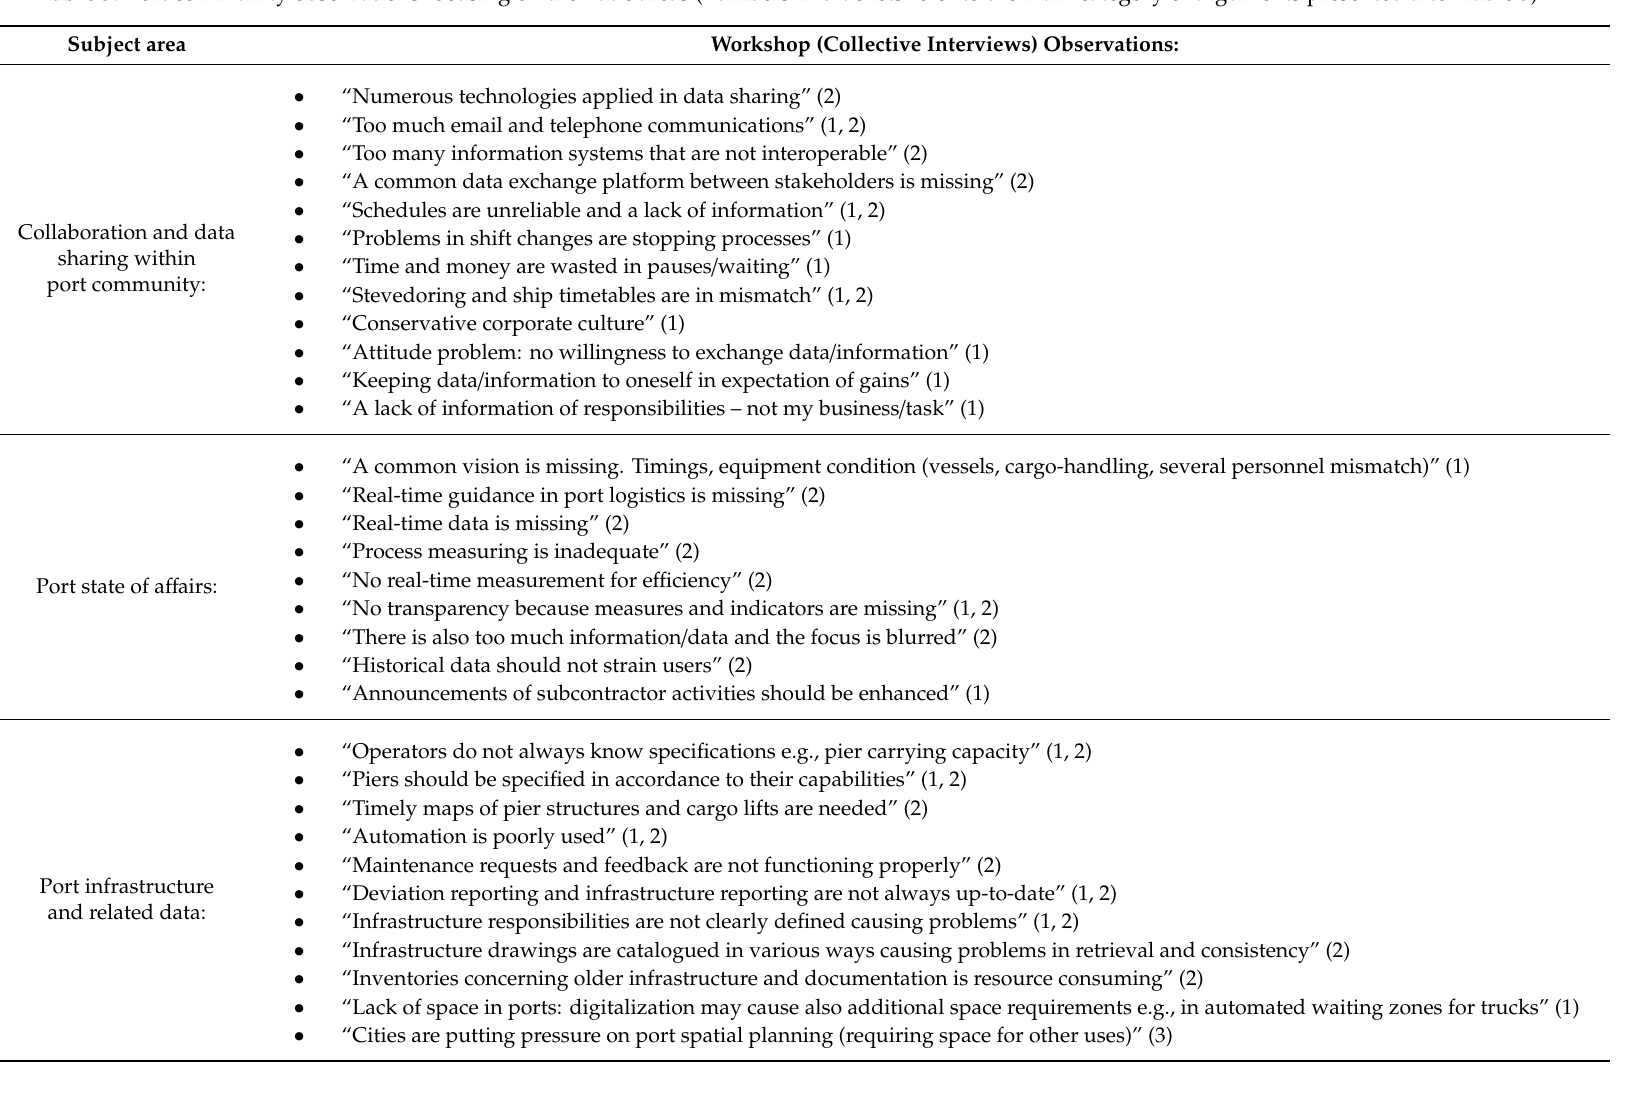
Table 3. Port community observations focusing on thematic areas (numbers in brackets refer to the main category of arguments presented after Table